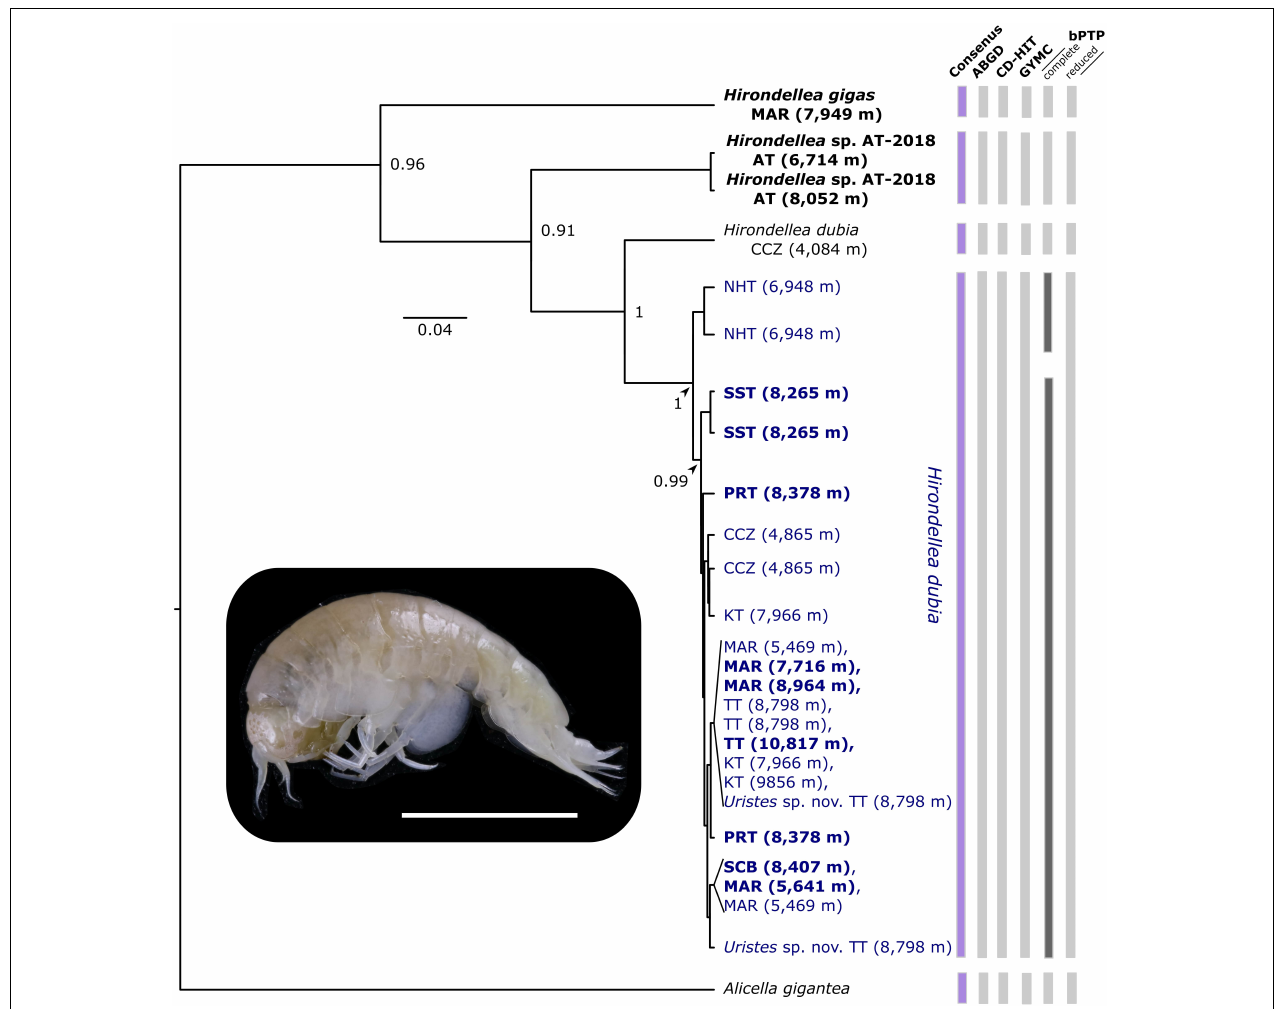
FIGURE 3 | Bayesian inferred tree showing species boundaries among the amphipod Hirondellea dubia (blue) individuals based on COI. Study-generated sequences are in bold. Results from the four molecular species delimitation methods are shown with vertical bars, with disagreements (dark gray) and consensus (purple) highlighted. Branch nodes show posterior probabilities > 0.7. Locations are abbreviated as, AT, Atacama Trench; CCZ, Clarion-Clipperton Zone; KT, Kermadec Trench; MAR, Mariana Trench; NHT, New Hebrides Trench; PRT, Puerto Rico Trench; SST, South Sandwich Trench; SCB, San Cristobal Trench; TT, Tonga Trench. Tip labels show collected depth (meters). See Supplementary Material 2 for the GenBank accession numbers. Photograph of H. dubia from 8,379 m at the Puerto Rico Trench, Atlantic Ocean (scale 5